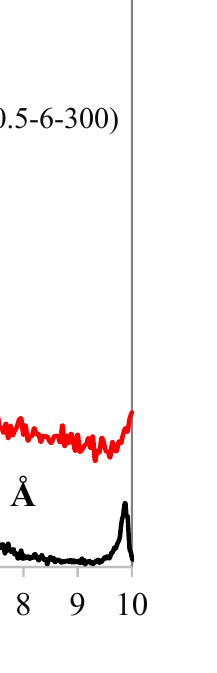
Figure 11. Low-angle X-ray diffraction and basal spacing of the raw clay and Ti-PILC (0.5-6-300). The normal XRD patterns of the Ti-PILC samples compared with the raw clay at large angles (2 θ = 10–60 ◦ ) are also shown in Figure 12. The presence of quartz (Q) and montmorillonite (M) was determined by detecting several peaks in the XRD pattern of the raw clay. It means that the pillaring process did not lead to the destruction of the main structure of the clay. On the other hand, the raw clay sample showed several peaks associated with the calcite (C) phase, which in the case of the Ti-PILCs, were